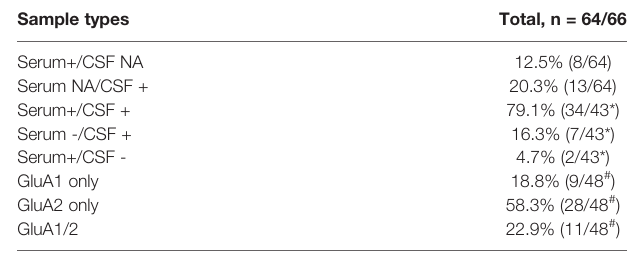
TABLE 3 | Summary of